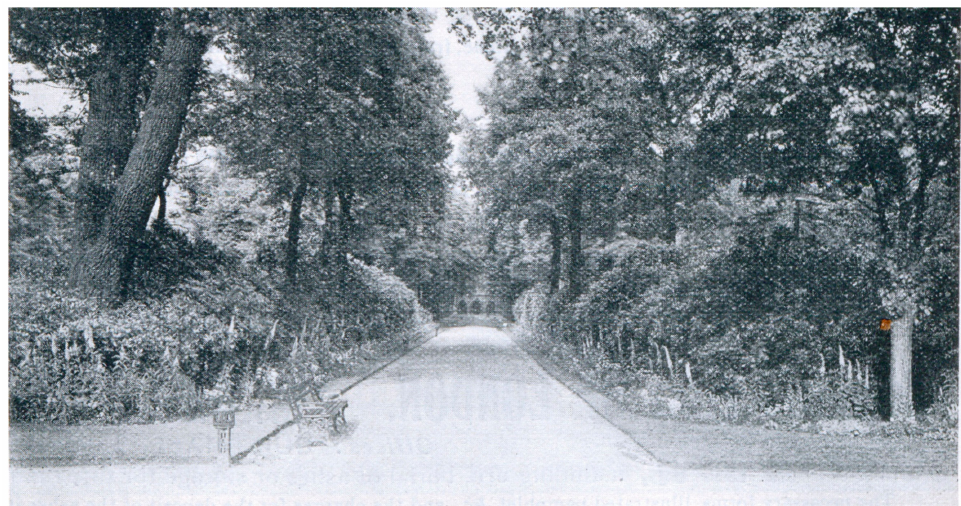
Figure 3. Robertson 3. A view towards the catacomb range in the City of London Cemetery